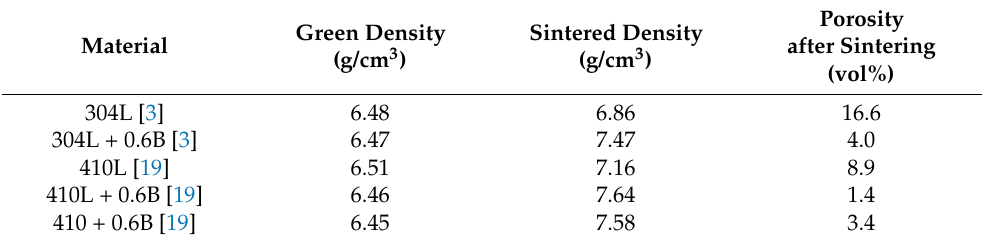
Table 2. The green densities, sintered densities, and porosities after sintering of the five stainless steels investigated in this